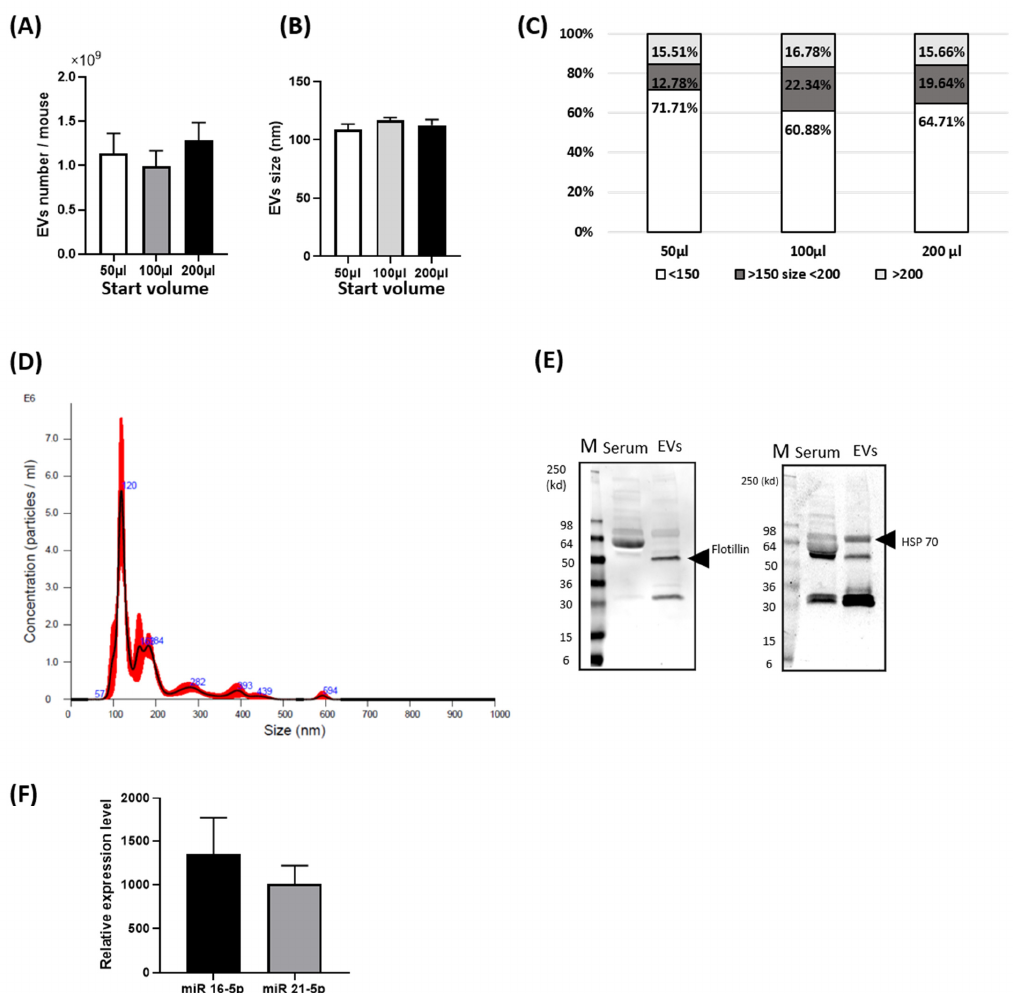
Figure 1. The basal characterization of mouse blood serum extracellular vesicle (EV) and verification of EVs miRNA: ( A ) Bar graph of EVs’ number measured by Nanosight in three different start serum volumes, 50 µL, 100 µL and 200 µL of mouse serum ( n = 5); ( B ) The bar graph of average exosome size measured in three different start serum volumes of mouse serum; ( C ) Bar graph of distribution of EVs’ size in three different start serum volumes of mouse serum. EVs’ size are categorized by less than 150 nm, between 150 to 200 and over 200 nm; ( D ) Representative histogram of EVs’ size distribution measured at 100 µL starting serum volume by Nanosight; ( E ) Immunoblot of five mice blood EVs’ pooling protein sample by anti-HSP70 Ab and anti-Flotillin Ab as EVs’ marker protein. Serum line loads same mouse blood serum protein amount as EVs’ sample; ( F ) Bar graph of relative expression level of miRNA (miR)-21-5p and miR-16-5p in mouse blood EVs measured by real-time PCR. The expression levels of two miRs were normalized by SNORD95, SNORD96A, RNU6-2 by RT-PCR. ( n = 5). Mean ± SE.